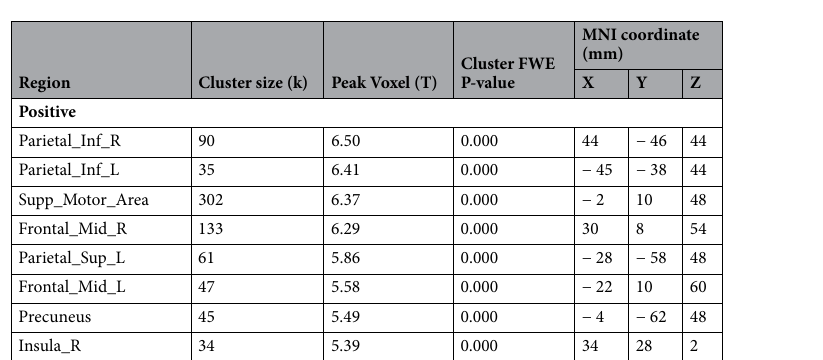
Table 3. Clusters showing correlation with PMAT24_A_CR, with age, sex, years of education as covariates. R right, L left.